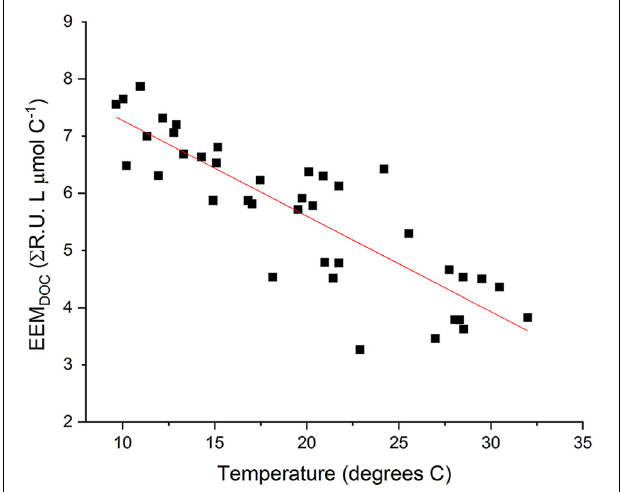
FIGURE 8 | Relationship observed between EEM DOC and temperature ( r 2 = 0.73; p < 0.001, n =